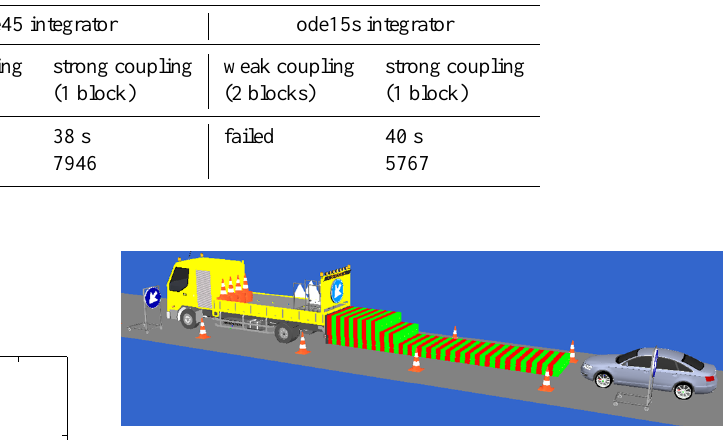
Figure 18. MBS model of a truck-mounted attenuator